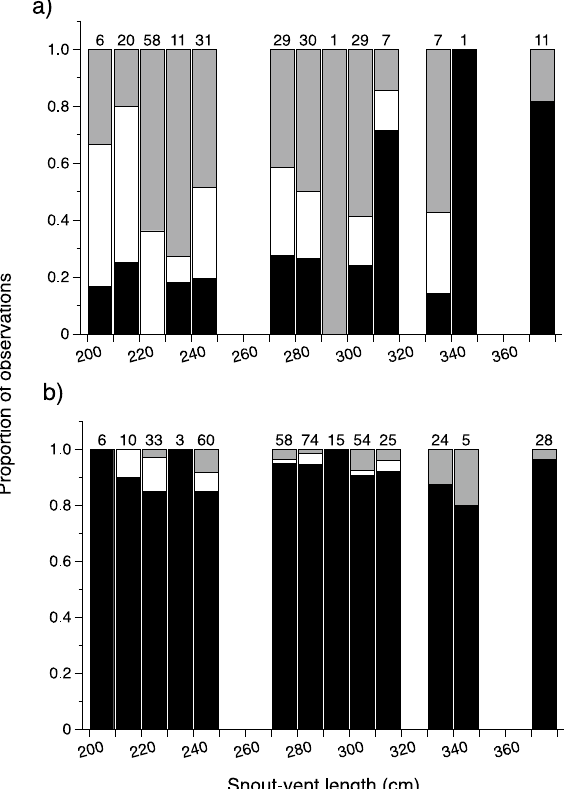
Figure 3. Proportion of observations of scrub pythons resting (black columns), moving (white columns), or hunting (grey columns) at ( a ) night and ( b ) during the day based on the snout-vent length of the snake. The number of observations made in each size class appear above the columns.